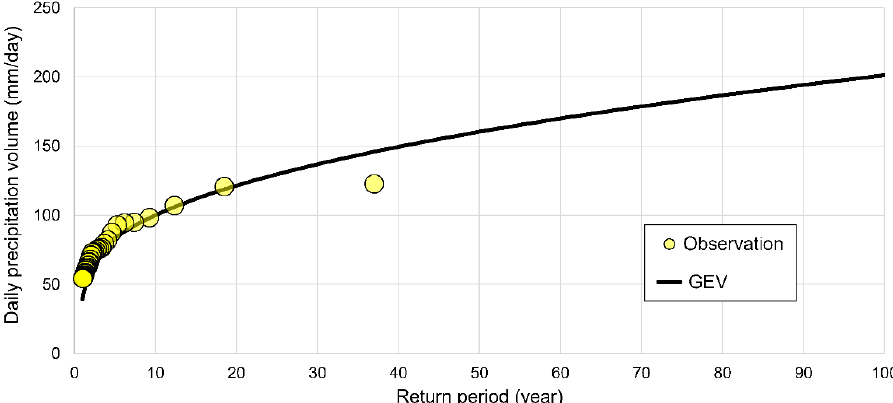
Figure 7. GEV distribution produced using observed daily precipitation records at Toncont í n Airport to obtain total precipitation volume with return periods from 1 to 100 years.